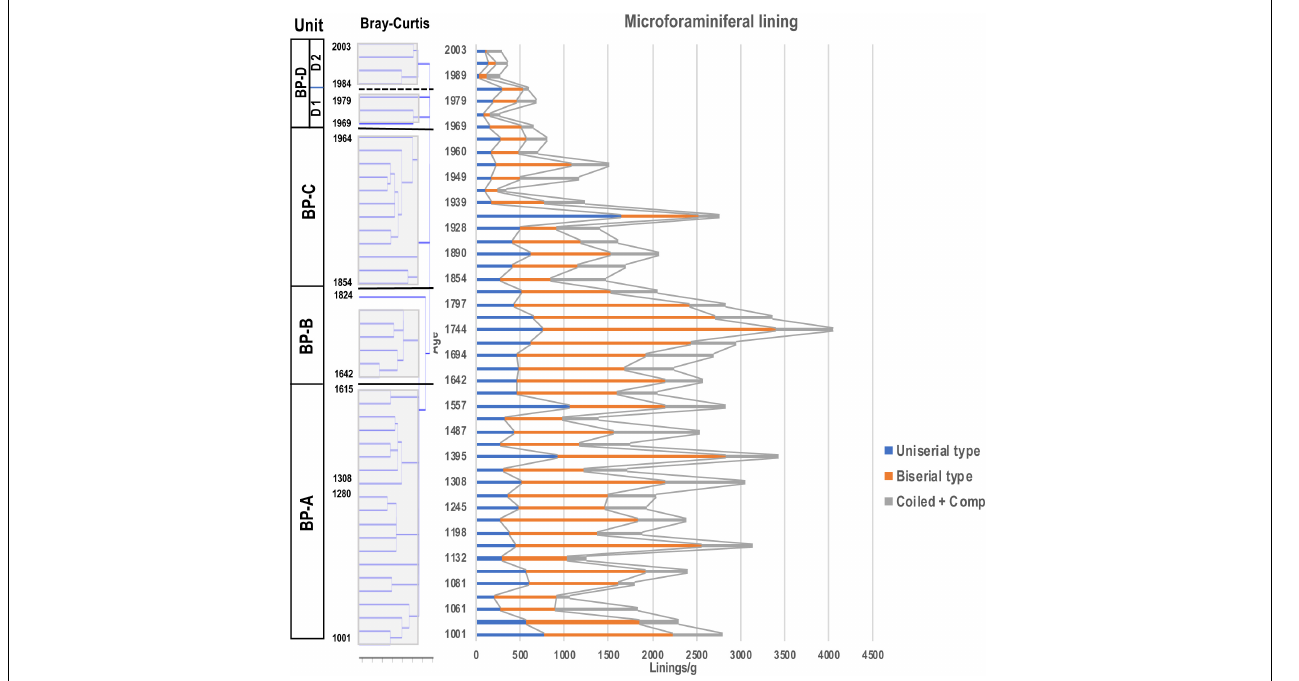
FIGURE 8 | Stratigraphic distribution of microforaminiferal linings. Unit division in the left column based on the result for dinoflagellate cyst assemblages resulting from stratigraphic cluster analysis using Bray-Curtis method.